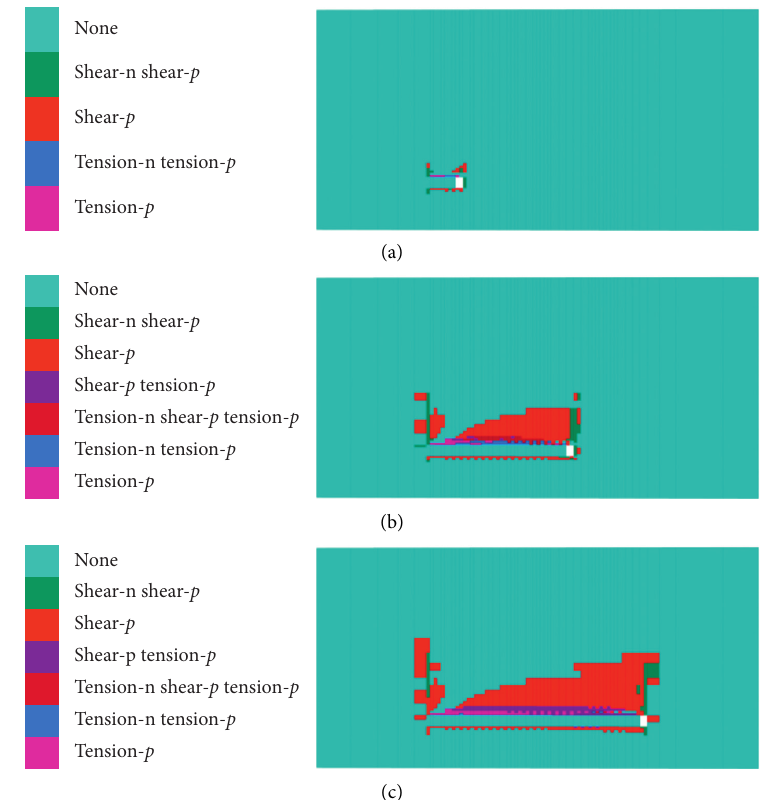
Figure 5: Overburden failure with working face advancement. (a) 70m has been excavated. (b) 210m has been excavated. (c) 300m has been excavated.